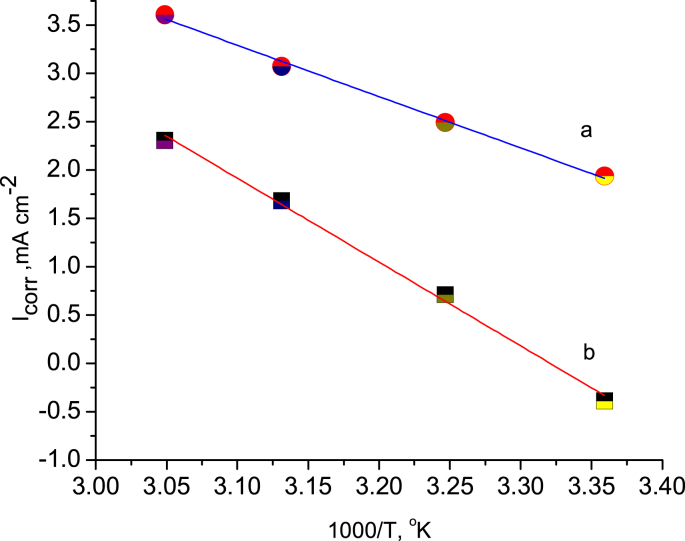
Arrhenius relationship for free H2SO4 a) without and b) with 1 mM of BQYP molecules.